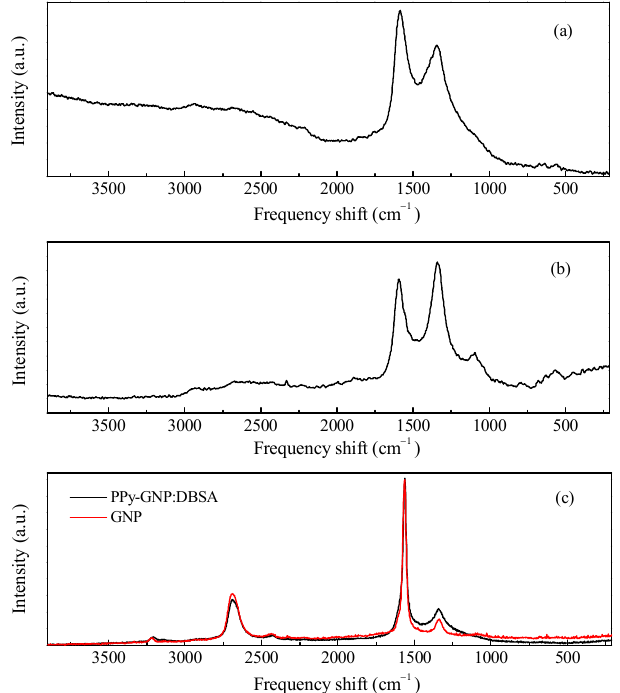
Figure 2. Raman spectra of the PPy powder ( a ), PPY-DBSA ( b ), and PPy-GNP:DBSA compared to GNP powder ( c ).